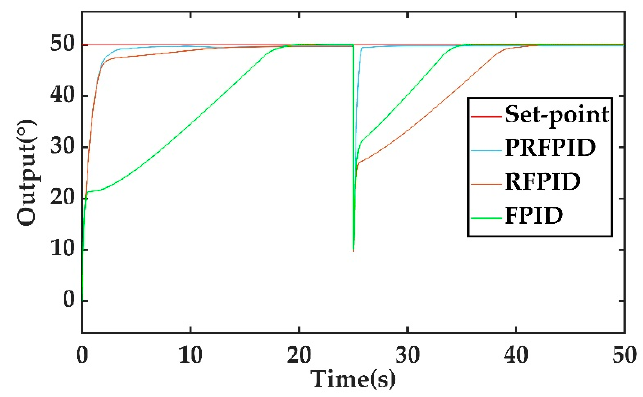
Figure 11. Step response under disturbance.